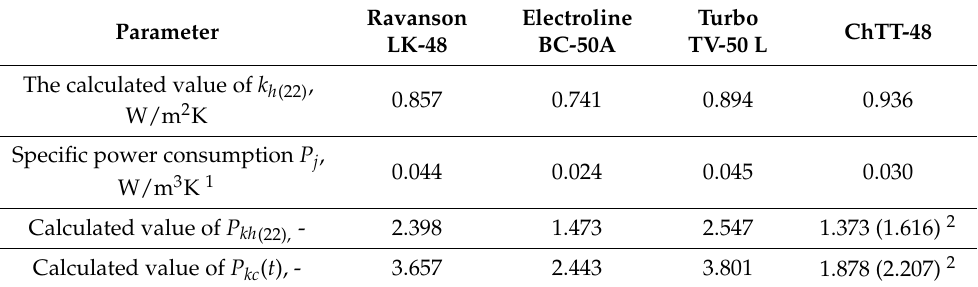
Table 3. Determined overall k coefficient of thermoelectric refrigerators of different manufacturers at ambient temperature of 22 °C and the heater heating power 17.4 W.